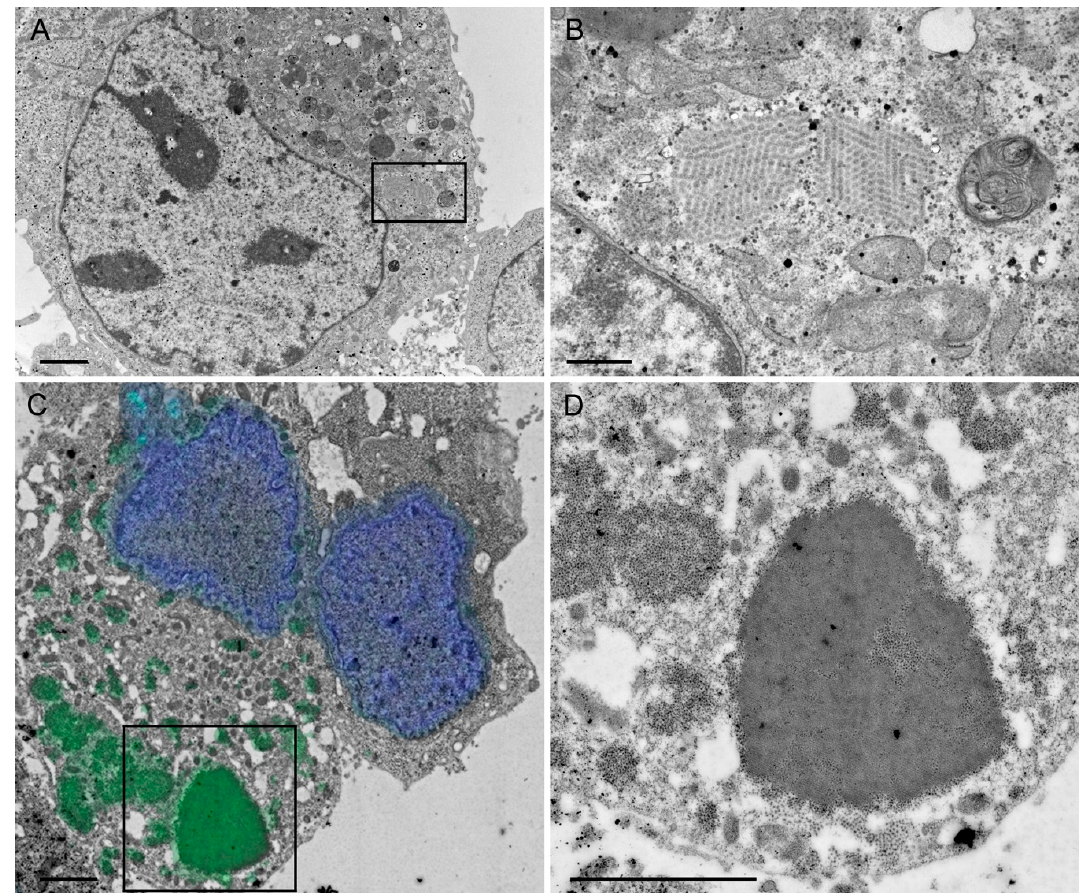
Figure 2. Ultrastructural analysis of transduced cells using electron microscopy. ( A , B ) Transmission electron micrographs of RVLP formation in the cytoplasm of vector-transduced cells. HepG2 cells were transduced (multiplicity of infection, MOI 5) with the HSV-1 amplicon vector sWa[VP2/6/7]. The cells were harvested 24 hpt from monolayers, processed as described in the material section and analyzed in a transmission electron microscope equipped with a charge-coupled device (CCD) camera. ( B ) Enlargement of the region marked in ( A ) showed clusters of regular circular structures found in the cytoplasm of the transduced cell. Scale bar: ( A ) 2 µm; ( B ) 0.5 µm. ( C , D ) Correlative light and electron microscopy. HepG2 cells were transduced (MOI 5) with the HSV-1 amplicon vector sWa[VP2/6/7_V5]. The cells were harvested 24 hpt from monolayers by pelleting and fixation with 4% formaldehyde and embedded in LR White. Ultrathin sections were directly collected on grids, prepared for immune fluorescence and images were taken using a fluorescence microscope. Thereafter, the same grids were further processed for electron microscopy. The fluorescent image was opened with the software Maps on the scanning electron microscope (SEM) computer, aligned with the secondary electron image and a tileset of images was recorded using the high-angle annular dark-field detector. ( C ) Overlay of the fluorescent and the electron microscope image of a stitched tileset of images covering the entire cell of interest. On the fluorescence micrograph, 4 ′ ,6-diamidino-2-phenylindole (DAPI) was used to stain the nuclei (blue), and RV proteins were stained using the anti-RV serum and the secondary antibody conjugated with Alexa-Fluor 488 (green). ( D ) Enlargement of the area of interest of the stitched tileset showing the highly RV-positive-marked electron-dense region marked in ( C ). Scale bar: ( C , D ) 1 µm. 2.3. Rotavirus Specific Antibody Response Induced by Immunization with sWa[VP2/6/7] We injected female mice with 10 6 transducing units (TU) per dose intramuscularly (i.m.) in a prime-boost regimen with sWa[VP2/6/7] or the GFP encoding amplicon vector as control.